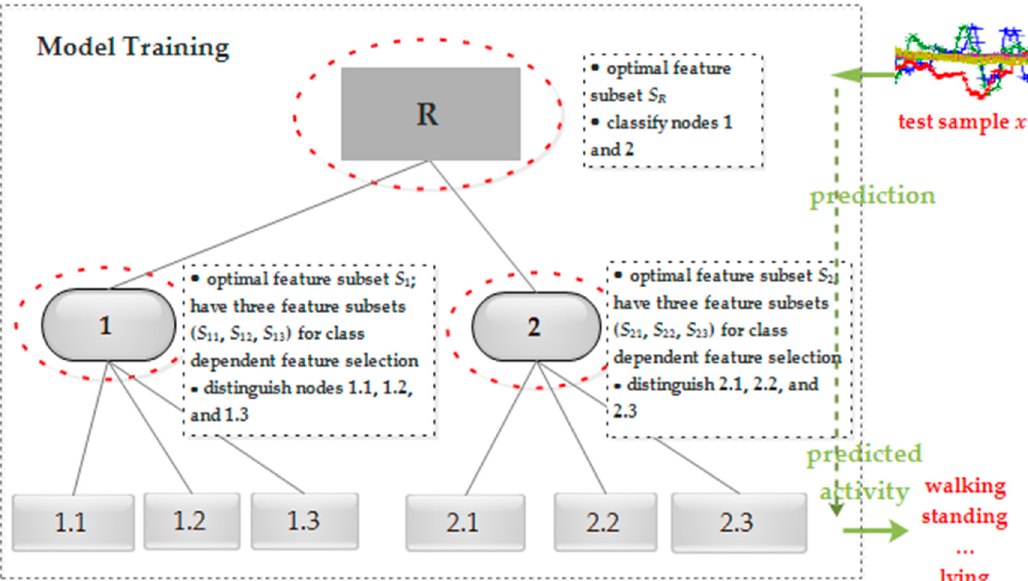
Figure 5. The proposed hierarchical activity recognition framework with feature selection integrated.